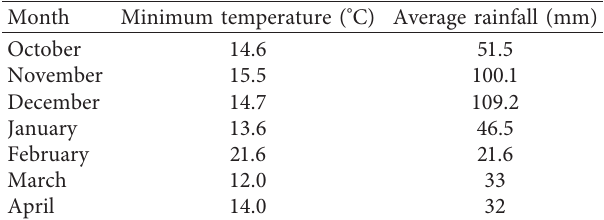
Table 1: Minimum temperature and rainfall data at Nyangati study site in Mwea subcounty, Kenya.